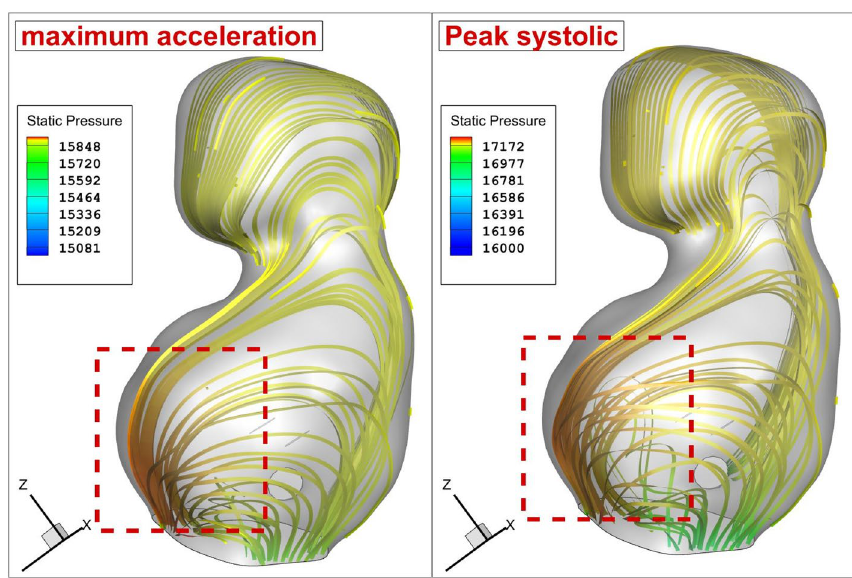
Figure 6. Blood flow with pressure